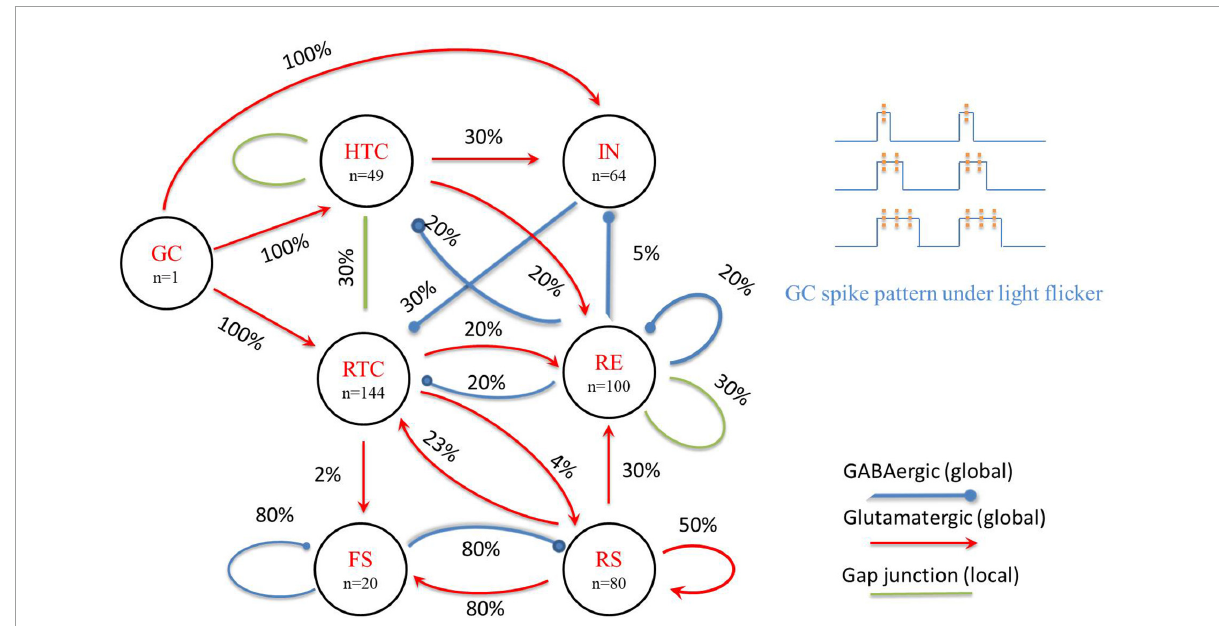
FIGURE1 A schematic of the proposed TCO NN model (left) and GC spike pattern under light flicker (upper right). The percentage value represents the possibility of a connection between neuron